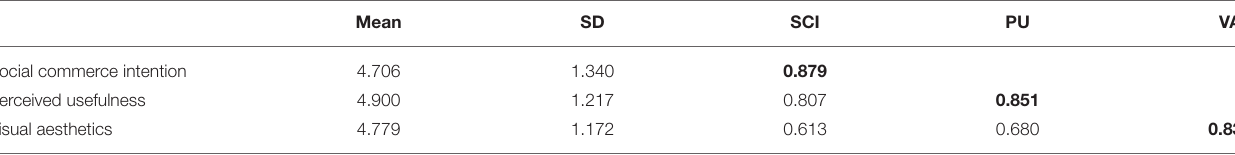
TABLE 2 | Discriminant validity of the constructs, mean, and standard deviation.